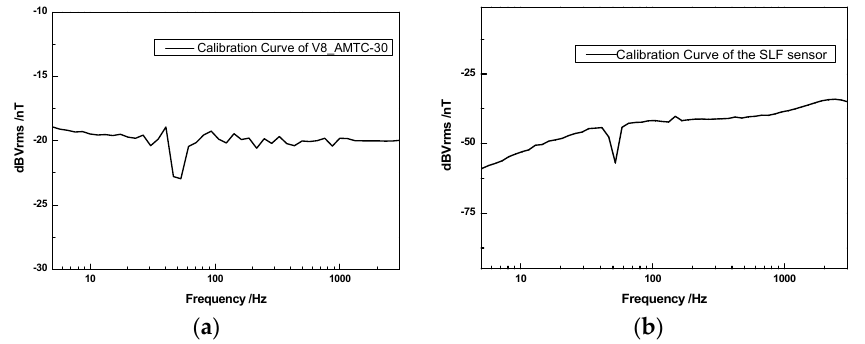
Figure 8. Comparison of calibration curves of ( a ) V8-audio-magnetotelluric method (V8-AMT) module and ( b ) magnetic sensor.